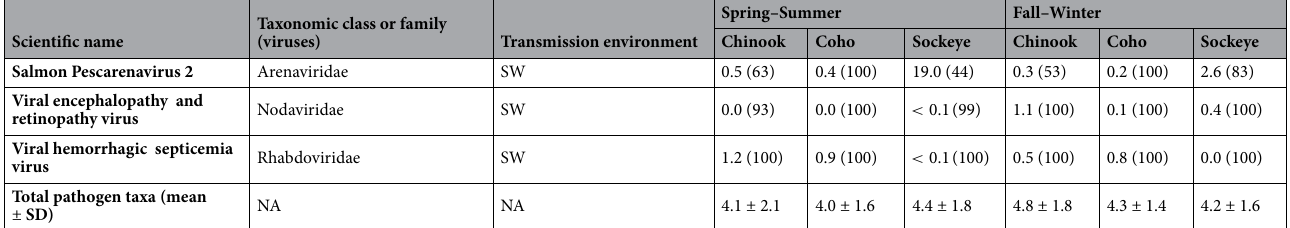
Table 1. Prevalence of infectious agents in Pacific salmon mixed-tissue marine samples (2008–2018) tested by HT-qRT-PCR (DFO Pacific Biological Station, Nanaimo, BC). Mean total pathogen taxa per individual with standard deviation is included at the bottom. Pathogen taxa with positive detections are in bold. Prevalence of each pathogen taxa is provided for each host species in both seasons (% of each group assayed for the given assay presented in parentheses). NAs indicate that no individuals from the given group were assayed (see “Methods”). Sample sizes were 2883, 1062, 2826 and 2836, 997, 561 for Chinook, Coho, and Sockeye salmon in spring-summer and fall-winter. Primer and probe sequences for each assay are available in Supplementary Material 1, Table S4. Transmission environments in italics are the presumed predominant environment, although transmission in both environments has been documented.